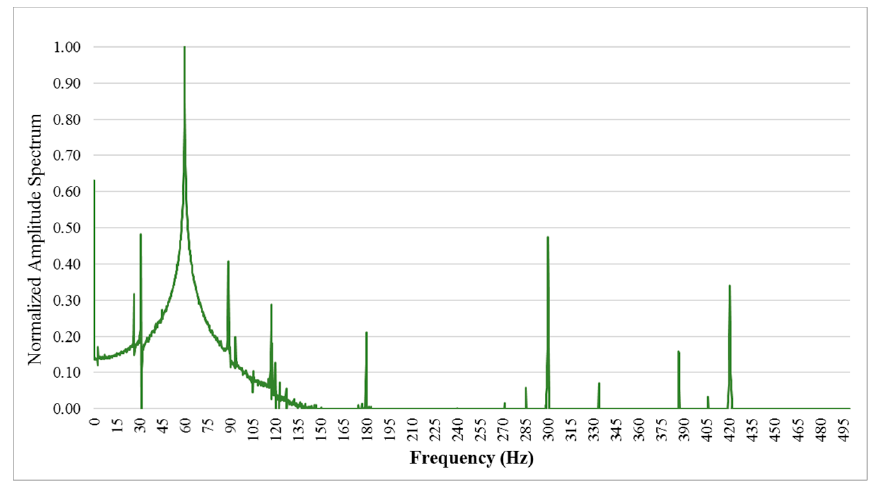
Figure 4. Frequency transformation of healthy motor condition with data preprocessing.